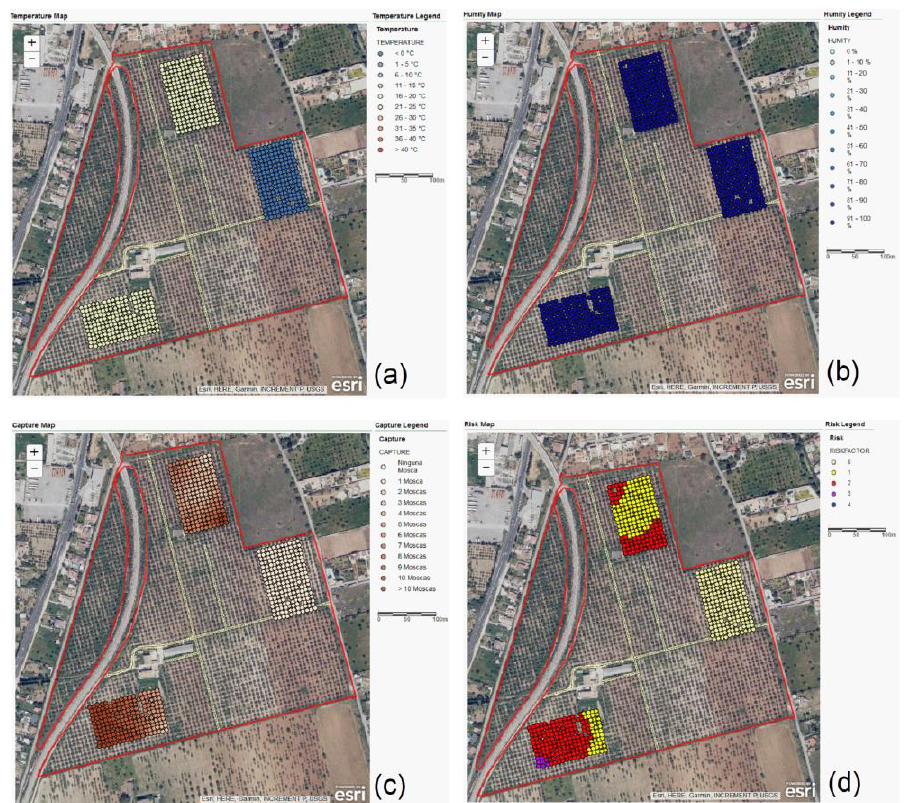
Figure 14. Output of the risk analysis of 27 October plotted using the OliveFlyNet application interface where ( a ) is temperature, ( b ) relative humidity ( c ) B. oleae adult captures (FTD)and ( d ) is a risk map where red color indicates areas where insecticide spraying is needed according with the parameters introduced into the DSS (C-PLAS Software).